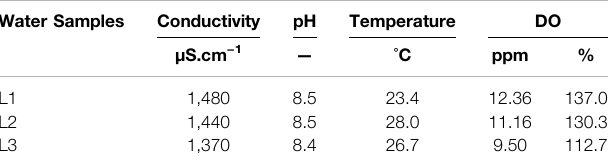
TABLE1| Physicochemicalparametersobtained insitu inwaterfromsitesL1,L2, and L3, Lugano Lake, Buenos